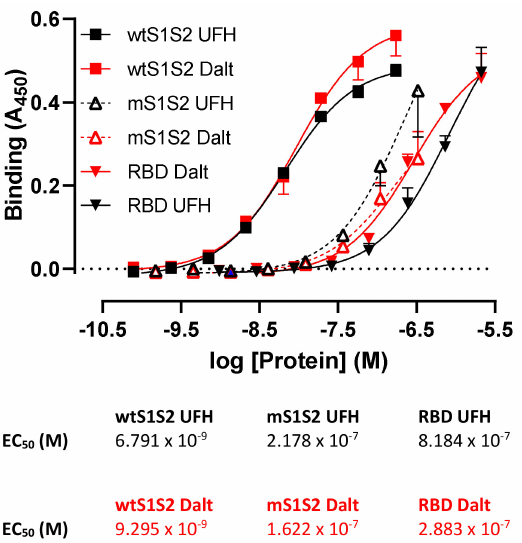
Figure 9. Spike protein binding to heparin requires a polybasic furin cleavage site. Unfraction- ated heparin (UFH) and low-molecular-weight heparin, dalteparin (Dalt) were immobilised on 96-well plates and used to detect the binding of wtS1S2, mS1S2 lacking the furin cleavage site (mS1S2) or RBD using a biotinylated anti-His6 antibody and streptavidin-HRP. Data shown are the means ± SD from 2–3 separate experiments performed in duplicate. Tables provide the EC 50 values for each